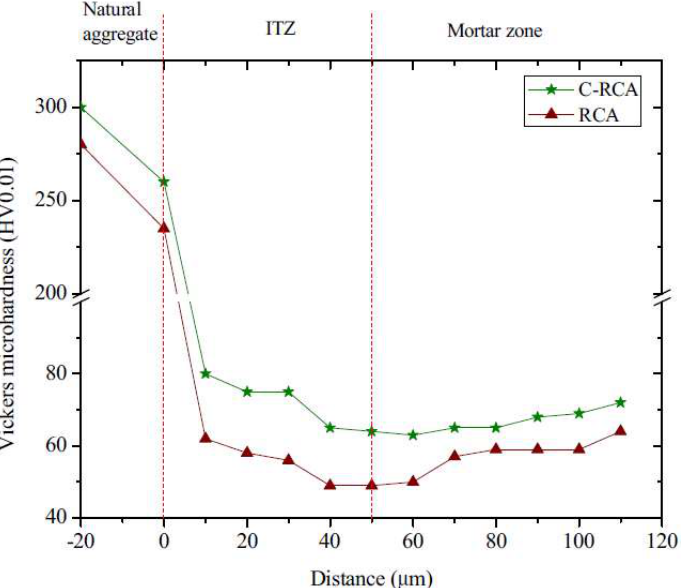
Figure 1. Vickers microhardness around RCA and carbonated RCA [6]. Reproduced with permission from [6], Elsevier, 2019.